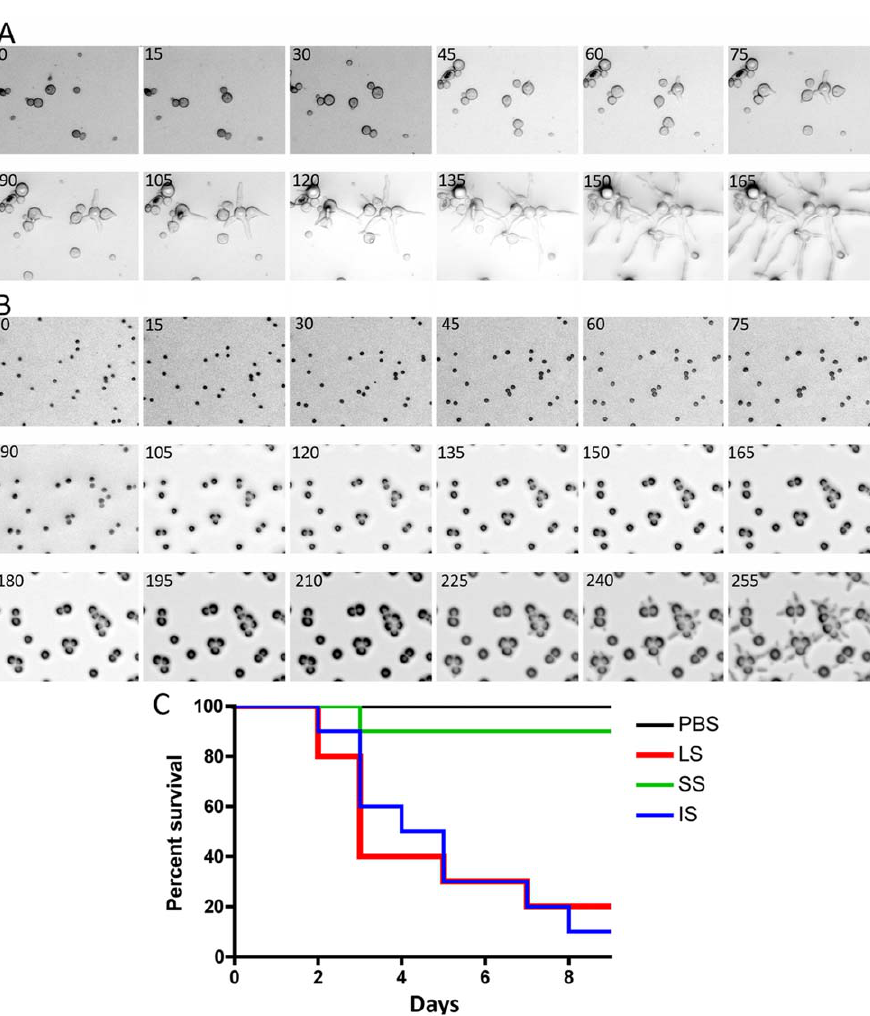
Figure 2. Delay in isotropic to polarized growth transition during germination of small vs. large spores. (A) Large spores (R7B) have a very short isotropic growth stage or bypass it entirely to send germ tubes. (B) Small spores (NRRL3631) grow isotropically to reach the size comparable to that of large spores, and then germ tubes emerge. Time-lapse (every , 15 min) images of each strain are presented. Note that in panel B, there are 3 rows of images to show the delay ( , 225 mins) prior to germ tube emergence in the smaller ( + ) spores. See Videos S1 and S2 for corresponding videos. Scale=40 m m. (C) When isotropically grown, the enlarged ( + ) spores became as virulent as larger spores in the wax moth larva host ( p